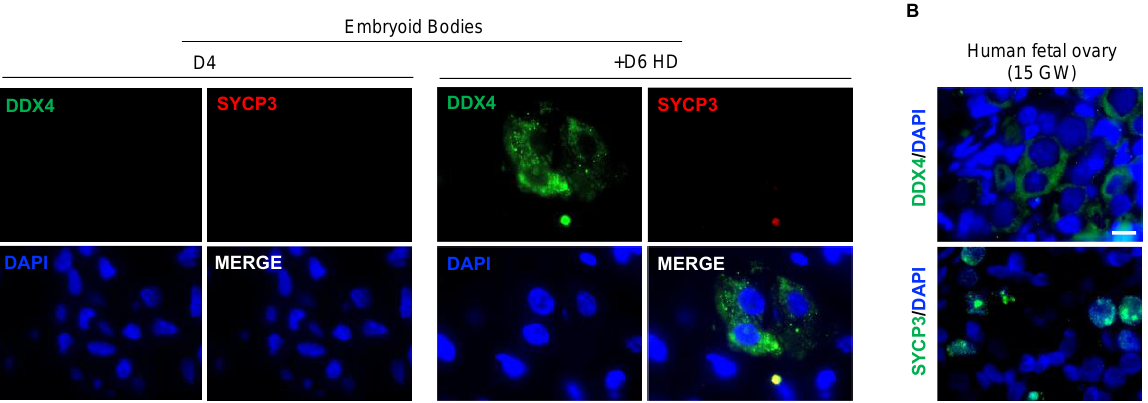
Figure 7. Assessment of late PGC and meiotic proteins expression in PB12 hiPSCs-derived EBs at day 4 and day 10. ( A ) Immunofluorescence analyses of DDX4 and SYCP3 proteins expression in PB12 hiPSCs-derived EBs at day 4 (left panel) and day 10 (right panel). Scale bar, 10 µm. ( B ) Immunofluorescence detection of DDX4 and SYCP3 proteins in 15 GW human fetal ovary, used as a positive control. Scale bar, 10 µm. +D6 HD: +Day 6 in hanging drop; EB D4: Embryoid Body at Day 4; GW: Gestational Week.